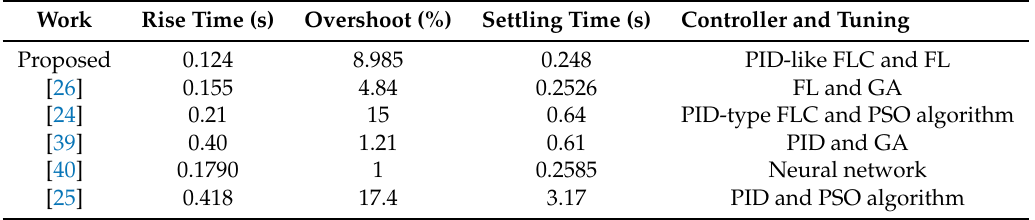
Table 4. Performance comparison among